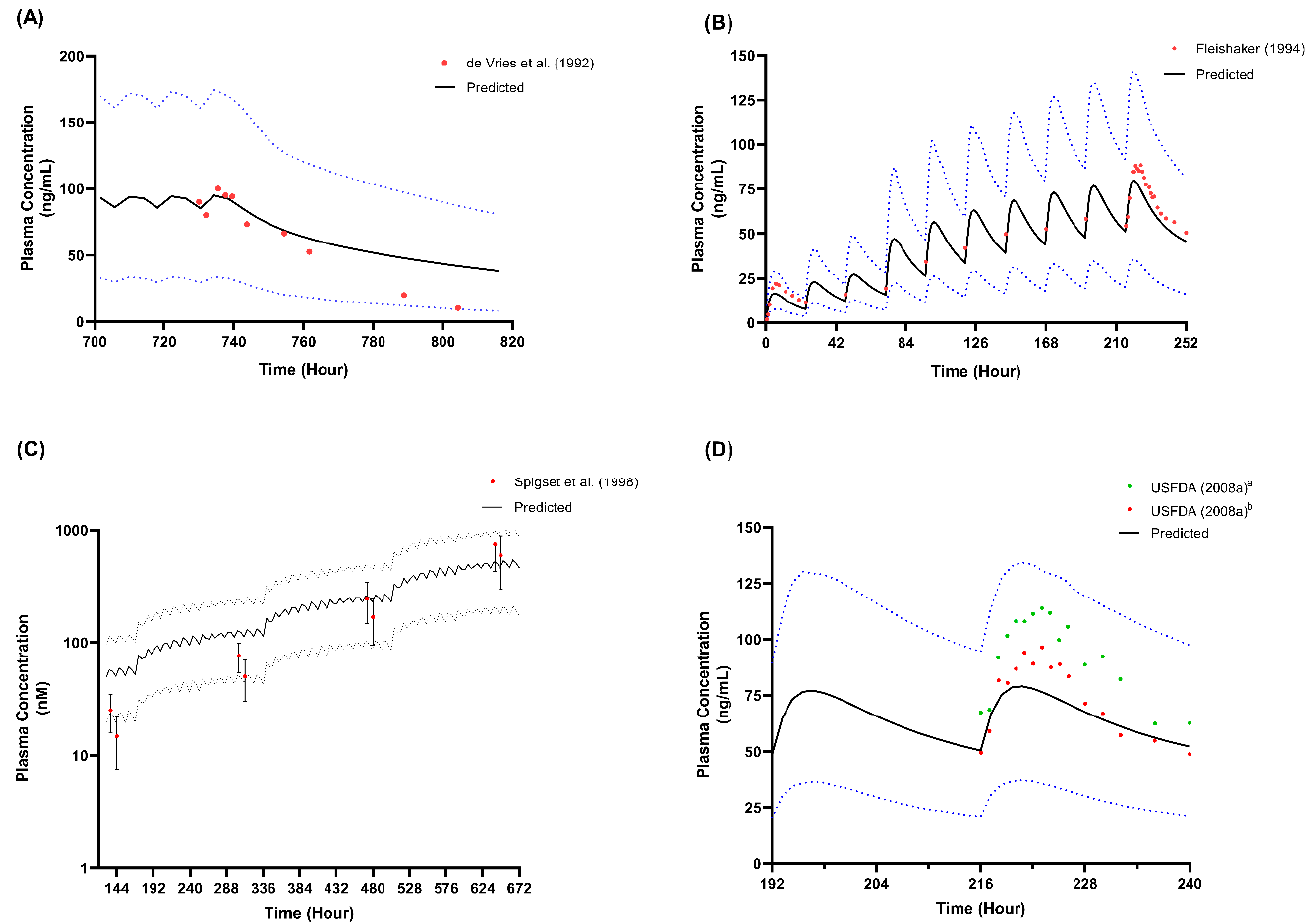
Figure 5. Multiple-dose studies simulated in model development and validation. ( A ) Multiple-dose 50 mg twice daily from day 4 to day 31 [42]; ( B ) multiple-dose 50 mg daily for 3 days followed by 100 mg daily for 7 days [43]; ( C ) multiple-dose 12.5 mg twice daily for week 1, 25 mg twice daily for week 2, 50 mg twice daily for week 3, and 100 mg twice daily for week 4 [47]; ( D ) multiple-dose 100 mg daily for 10 days [46]. Solid lines represent the mean predicted concentration-time profile, with dotted lines representing the 5th and 95th percentile ranges. Solid circles represent observed clinical data from each study, with error bars indicating SD. USFDA (2008) a represents a bioavailability study with prototype D [46]; USFDA (2008) b represents a bioavailability study with prototype C [46]. The validation of the predicted values overlayed with the observed plasma concentrations for the graphs of the CYP2D6 EM and PM populations are presented in Figures 6 and 7. Regarding the comparison of the pharmacokinetics parameters, a few parameters that were not within the 2-fold range were only seen in the single-dose 50 mg study by Spigest et al. [49] concerning the AUC inf in both the EM and PM and the AUC 0-t for the PM, as well as the C max for PM CYP2D6 for the single-dose 50 mg study by Carrilo et al.